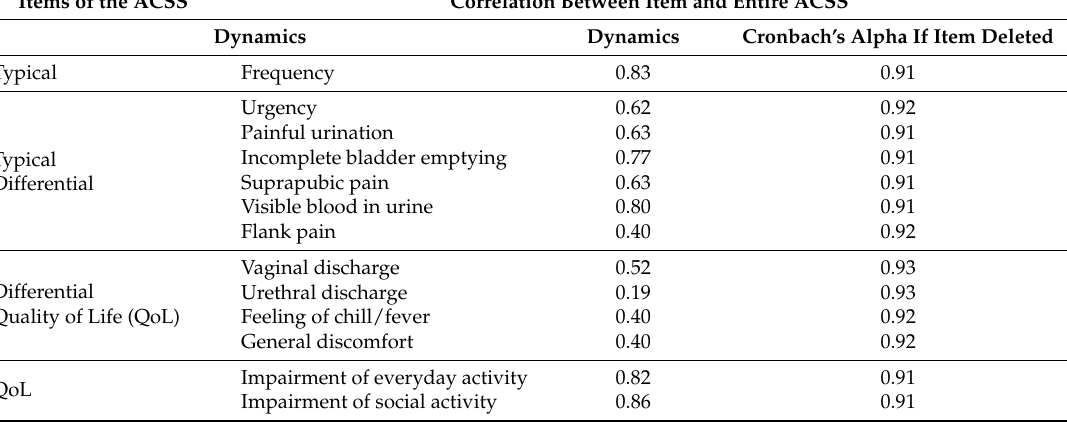
Table 2. Values of current internal consistency, alpha ‘if item deleted’ and item-total correlations for ACSS